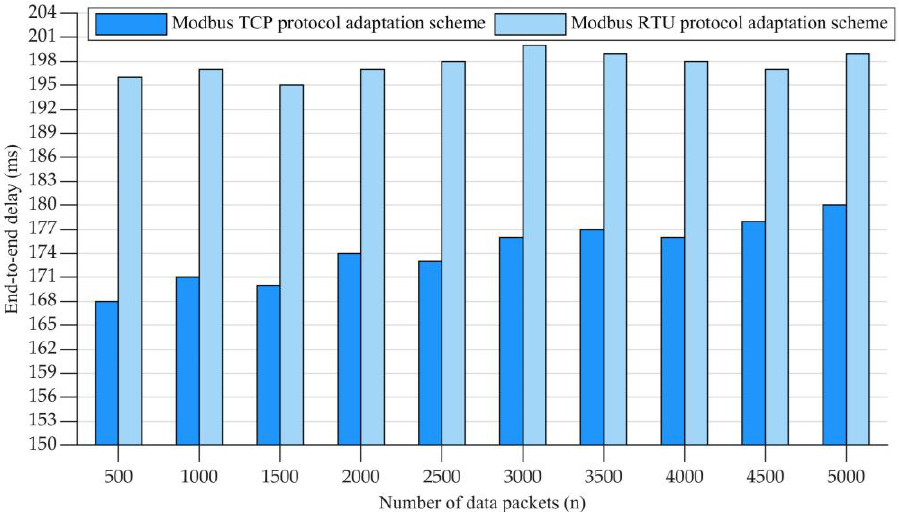
Figure 18. The end-to-end delay comparison between Modbus RTU and Modbus TCP for protocol adaptation.